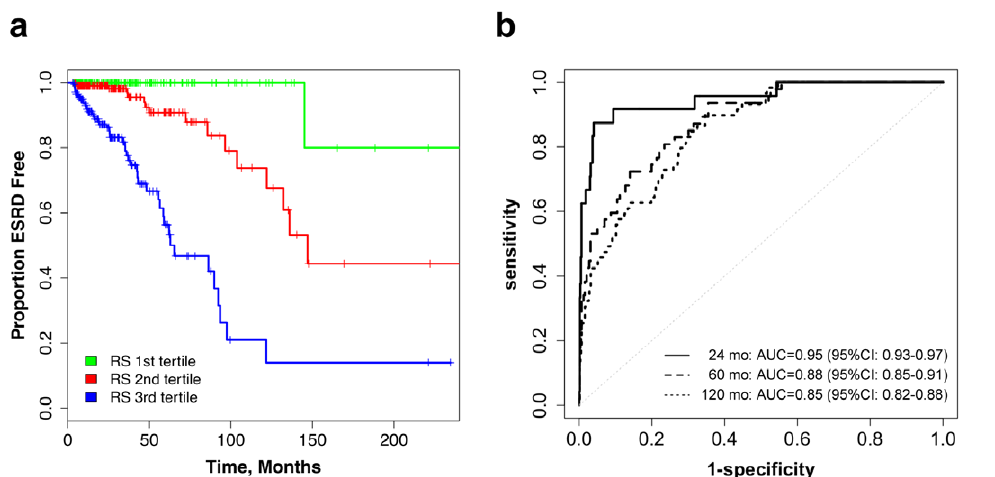
Figure 3. Survival and Survival ROC curves for the Risk Score. (a) Kaplan-Meier outcome-free survival curves by risk score tertiles; (b) the Risk Score’s ROC curves for predicting ESRD at 24 months, 60 months and 120 months.